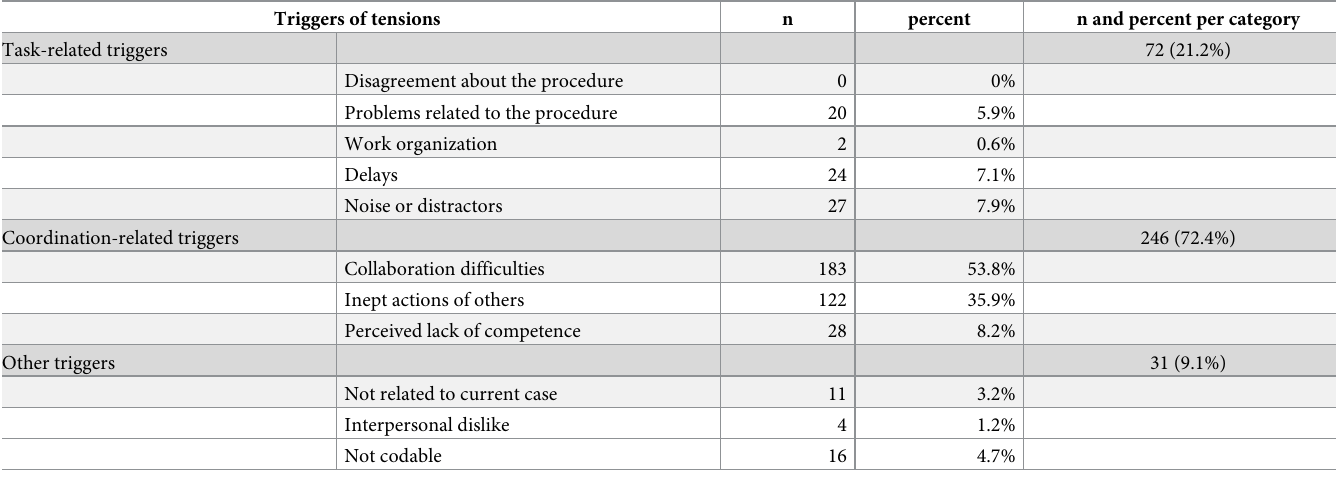
Table 4. Triggers of tensions.